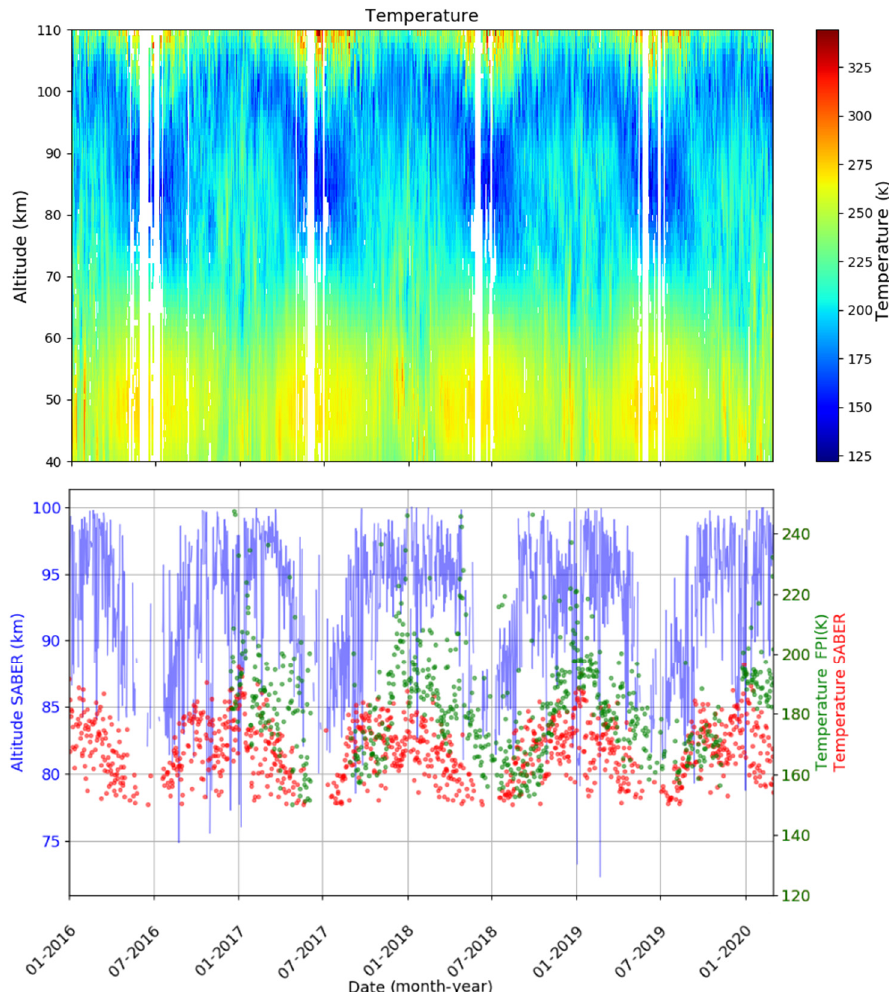
Figure 1. Top —behavior of temperature height profile above the GPO in Tory from SABER data. Bottom —variations in the mesopause height (blue line) and temperature obtained from SABER data at an altitude 94 km (red points) and temperature from FPI data (green points). The presented data cover the 2016–2020 time interval.